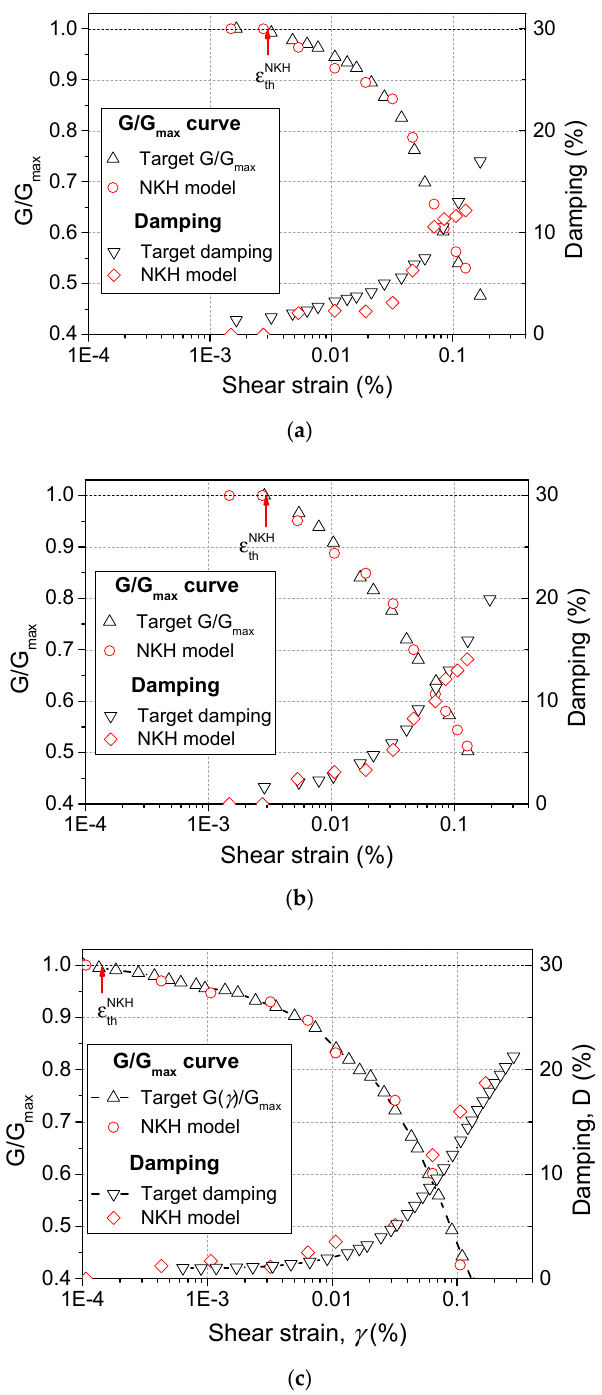
Figure 4. G/Gmax and damping curves in the NKH model for ( a ) silica sand, ( b ) mixture soil, and ( c ) Toyoura sand. ( c ) Toyoura